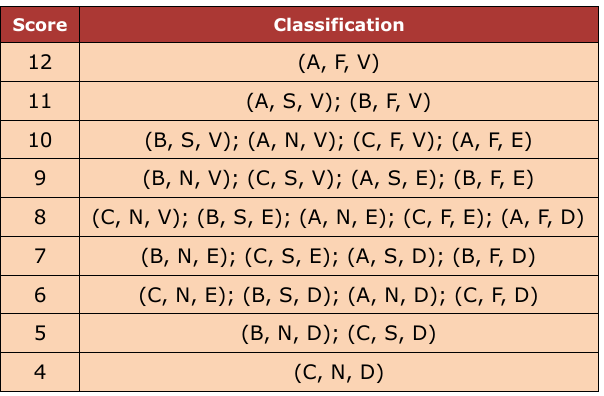
Table 4. Mixed priority levels for all three